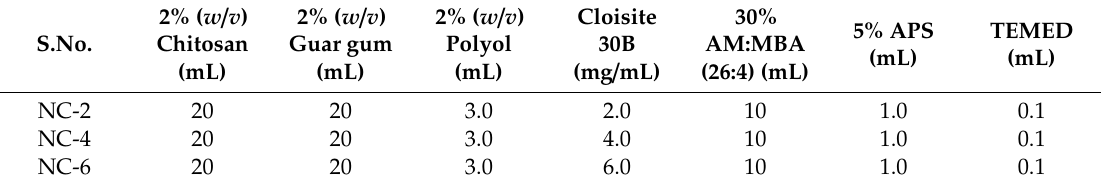
Table 2. Feed compositions of